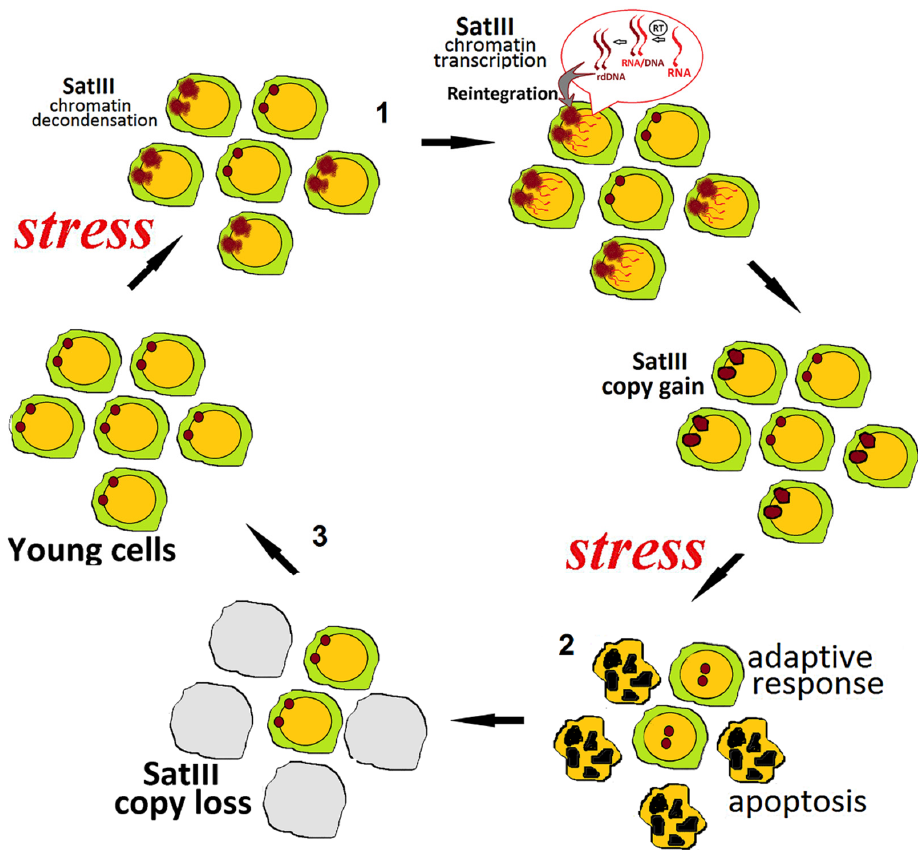
Figure 1. A “pendulum” model of the dynamics of SatIII copy number. (1) The mechanism of SatIII expansion in a fraction of cells under stress or aging; (2) cells with excessively large SatIII clusters perish during the repeated stress; (3) the low copy number (“reserve stock”) cells have survived and given rise to the future generations, which can then accrue their SatIII copy number and thus repeat the cycle.